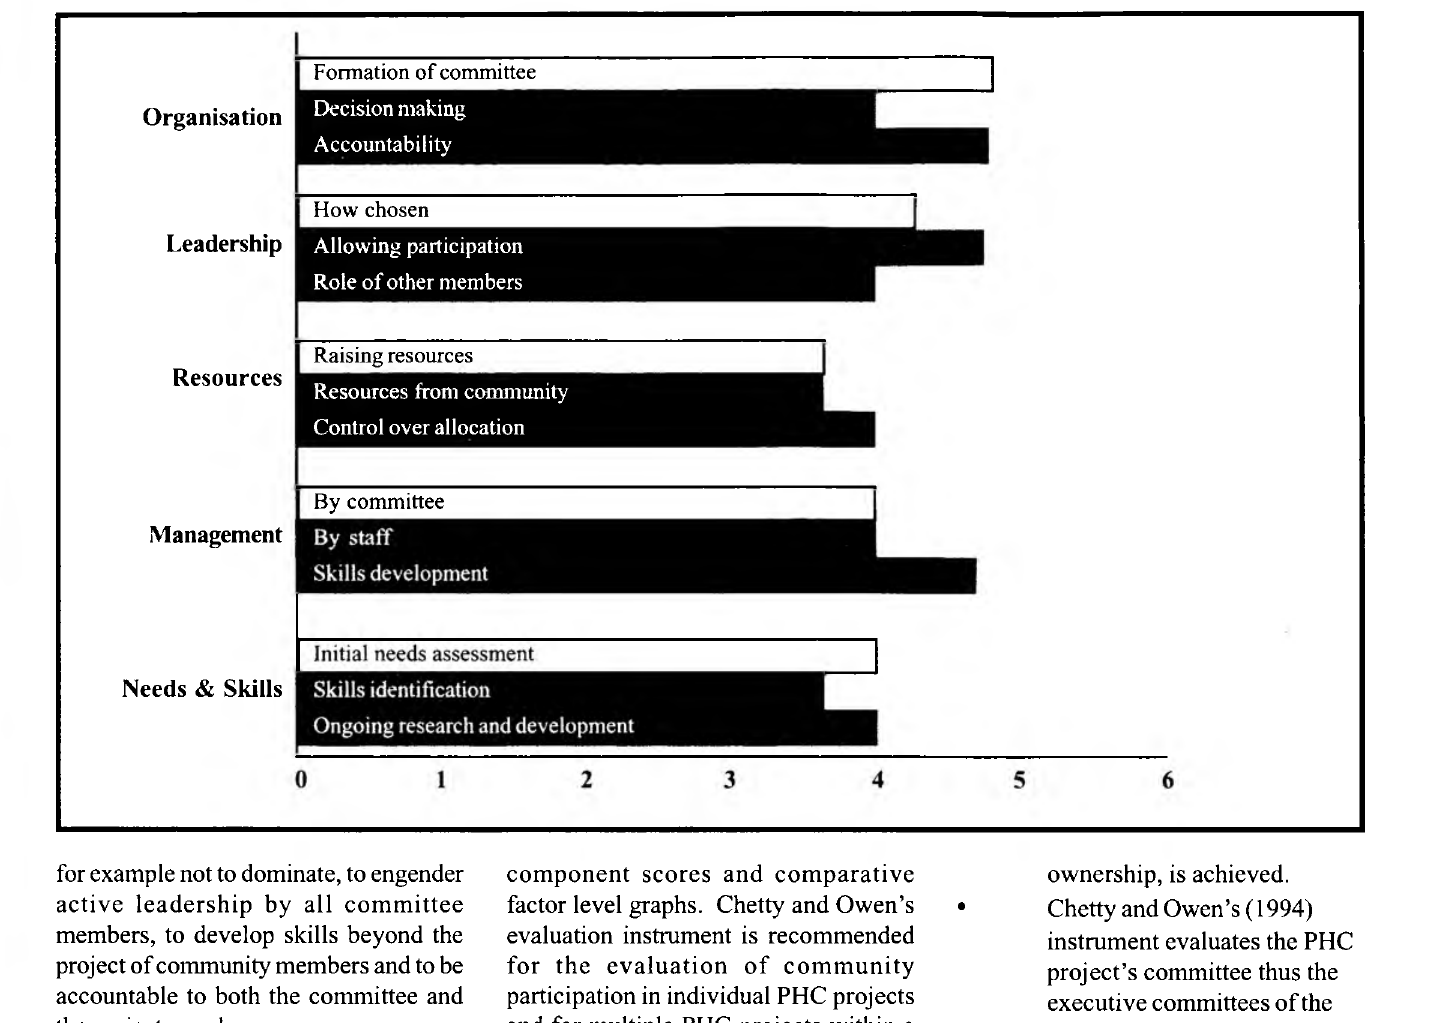
Figure 3. The MHDP’s composite component